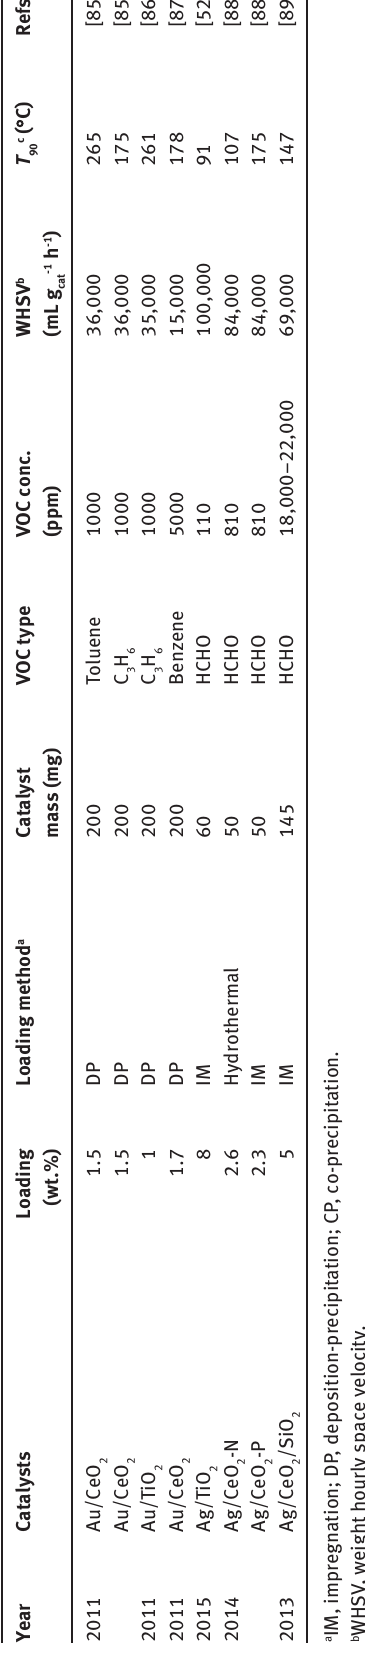
O absorbents and (B) the concentra- 2 3 as a function of reaction time for Pt/ 2 O and Pt/TiO catalysts. Reproduced 2 3 2